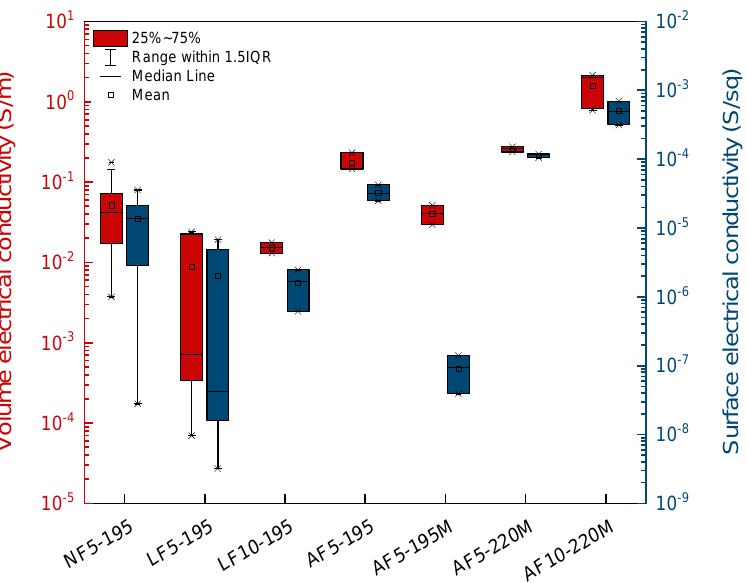
Figure 4. Influence of operational parameters on volume (red) and surface (blue) electrical conductivity (per square) (asterisks represent the outliers).